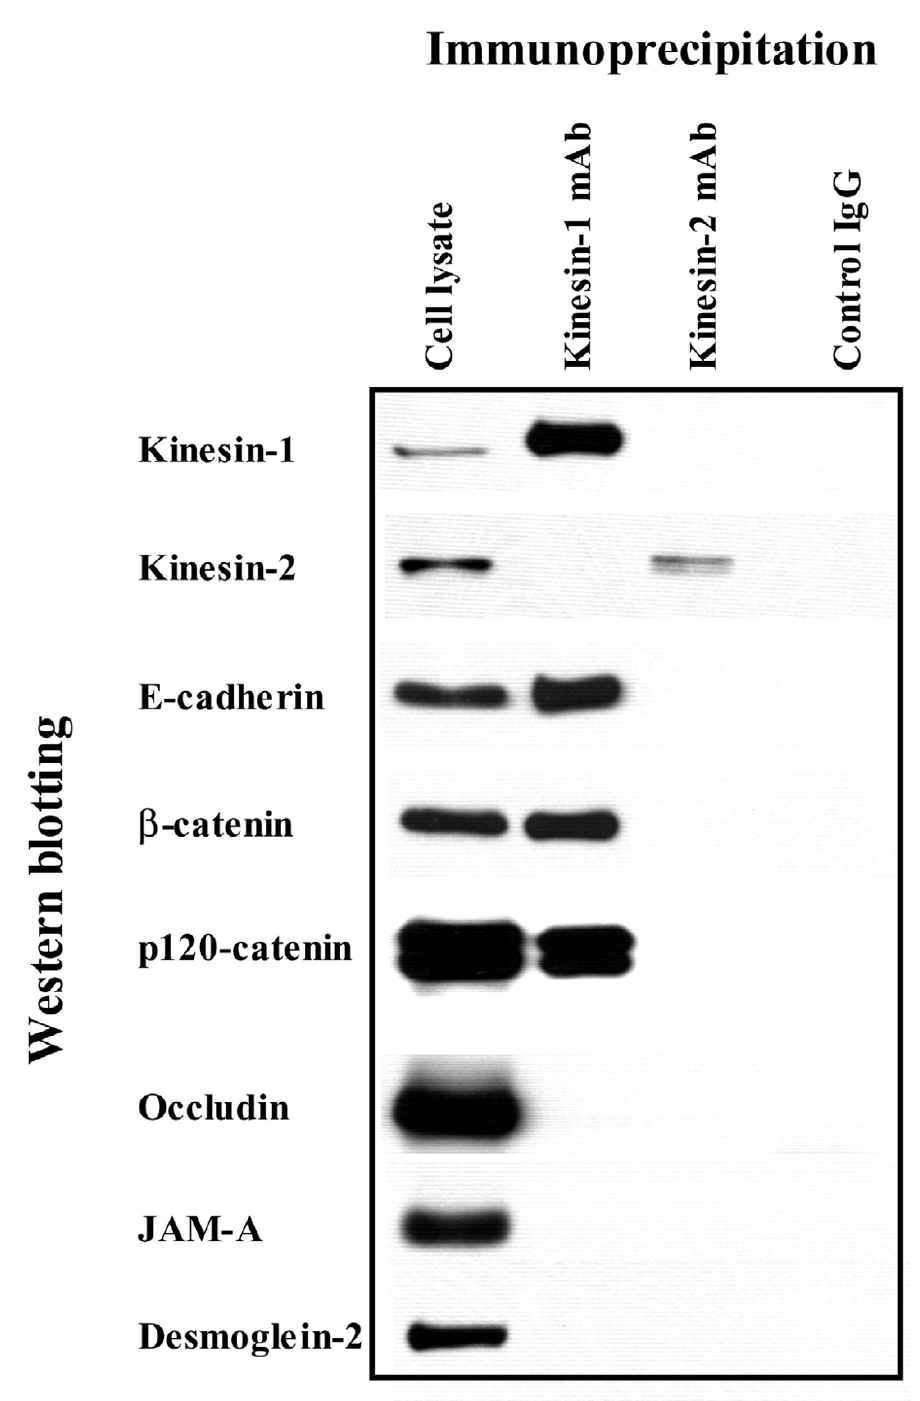
Figure 10 Association of kinesin-1 with AJ proteins. T84 cell lysates were immunoprecipitated with either anti-kinesin-1 heavy chain antibody, anti-kinesin-2 heavy chain antibody, or control mouse IgG and immunoblotted for different junctional proteins as described in the Methods section. Kinesin-1 co-precipitates with AJ proteins E-cadherin, β -catenin and p120 catenin, but not with TJ proteins occludin and JAM-A or desmosomal component desmoglein-2. No co-pecipitation of any tested junctional protein with either kinesin-2 or control IgG is